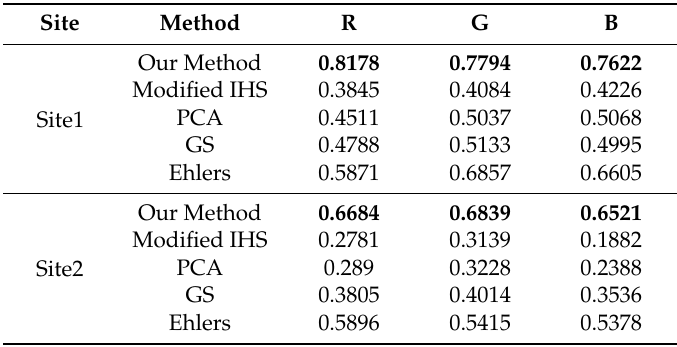
Table 3. Correlation coefficient (CC) between the fused KOMPSAT-5 images and the criterion Landsat-8 OLI image.